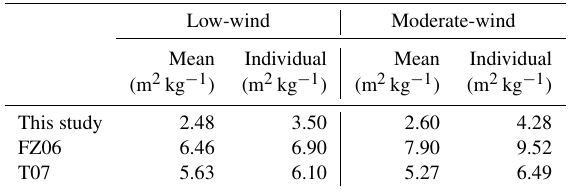
Table 2. RMSE values for model evaluation. Model predictions are compared with observations for both the daily mean SSA val- ues (Mean) and the 10 individual SSA measurements (Individual). For the low-wind events, α in Eq. (5) is − 0 . 41m 2 kg − 1 d − 1 . For moderate-wind events α in Eq. (5) is − 0 . 66m 2 kg − 1 d − 1 . FZ06 parameters τ and n are defined from the look-up table in Flanner and Zender (2006). T07 uses the mean surface temperature for each event as an input